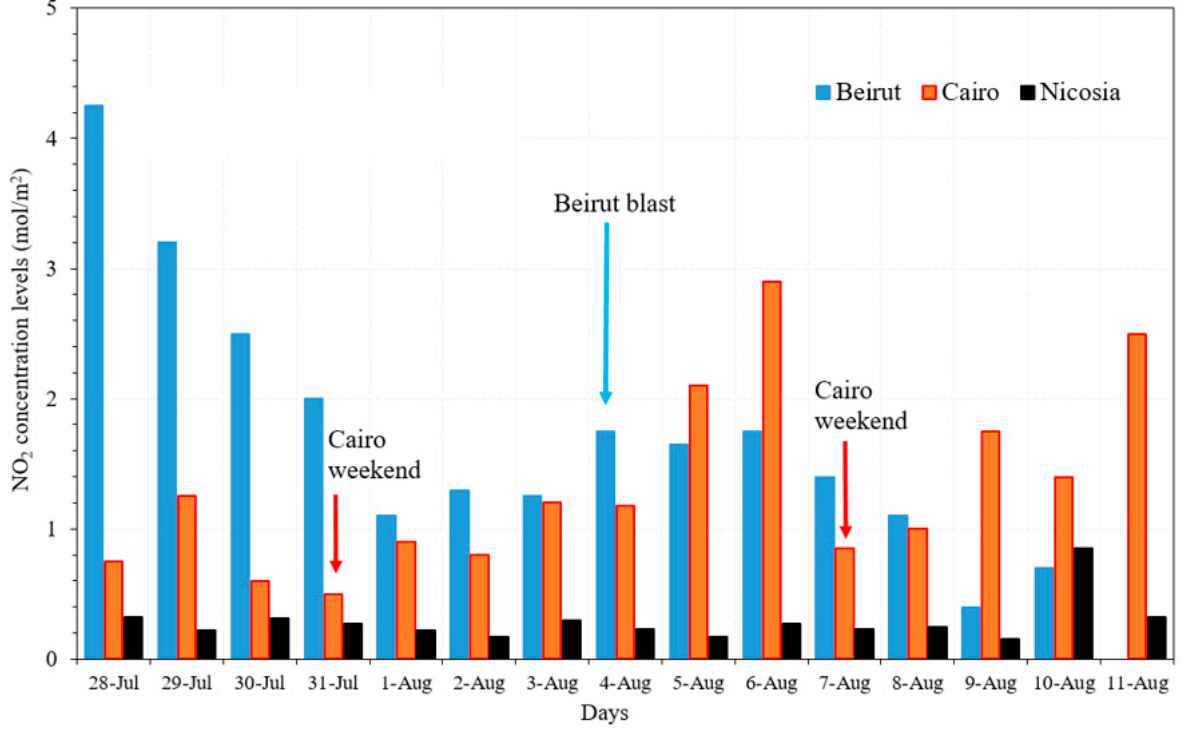
Figure 8. Comparison of NO 2 concentration over Beirut, Cairo, and Nicosia from 28 July to 11 August 2020.